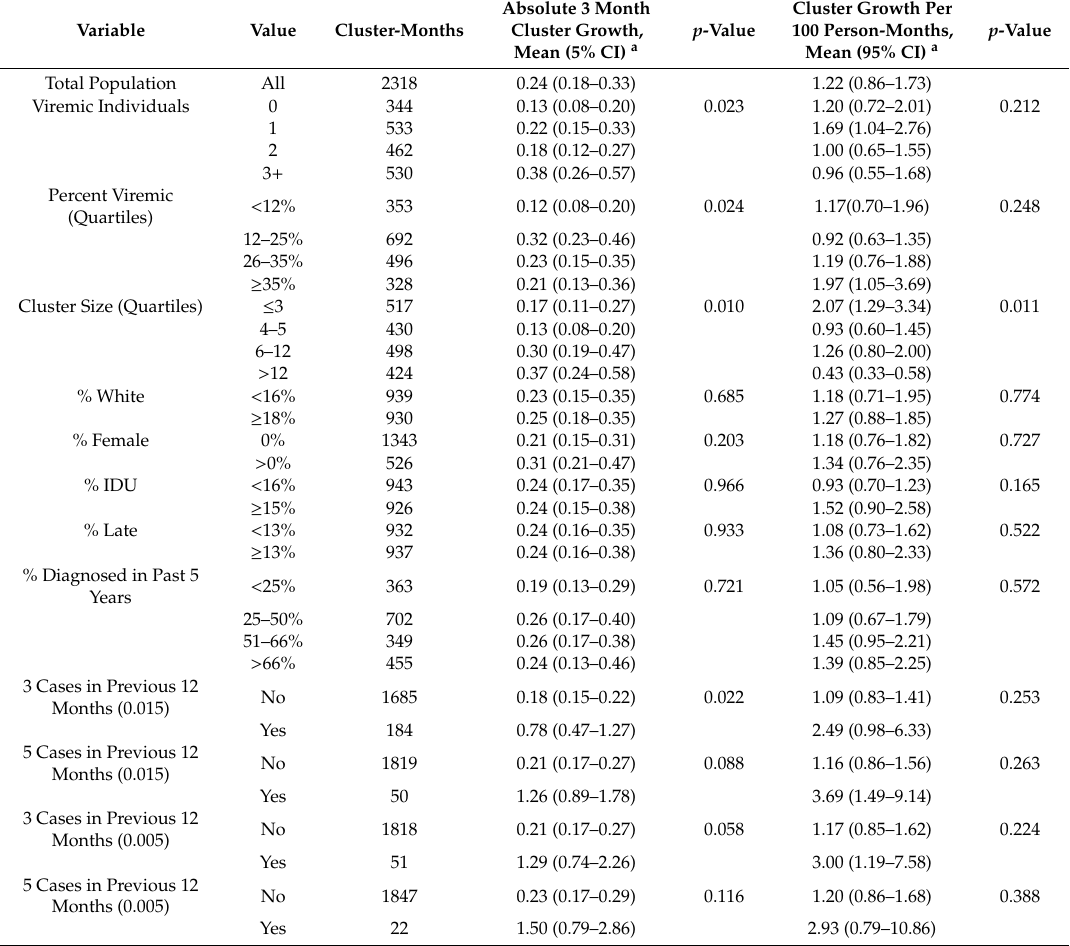
Table 4. Cluster growth rates in subsequent three-month period by cluster attribute, Washington State